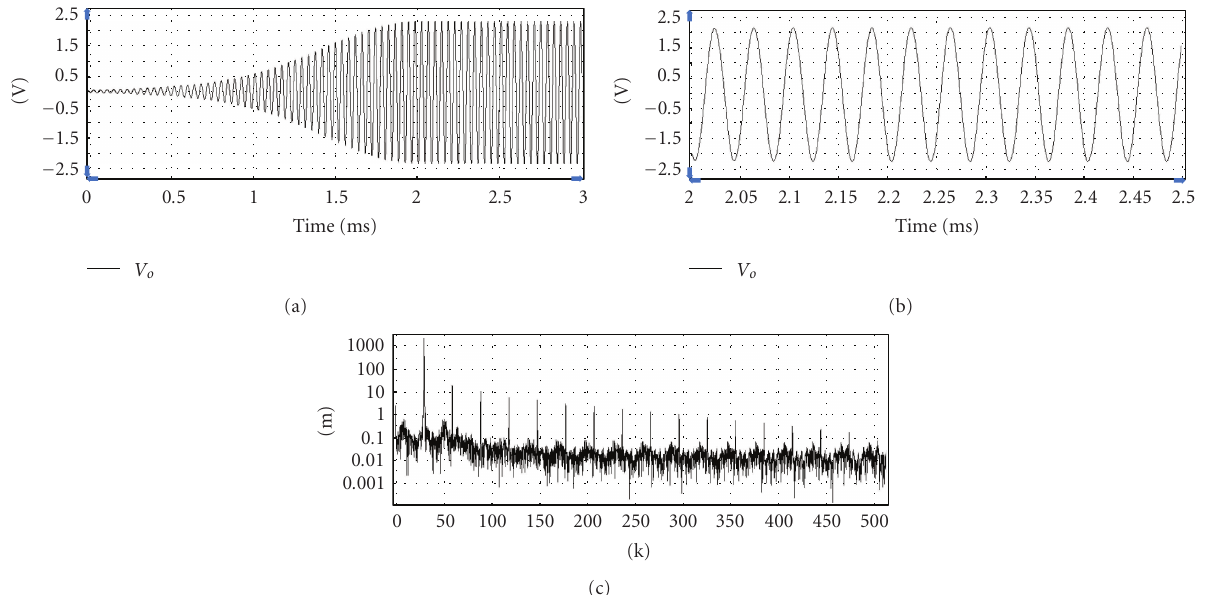
Figure 5: Oscillator in Figure 1(c): (a) startup of oscillations, (b) steady-state waveform, and (c) magnitude spectrum.